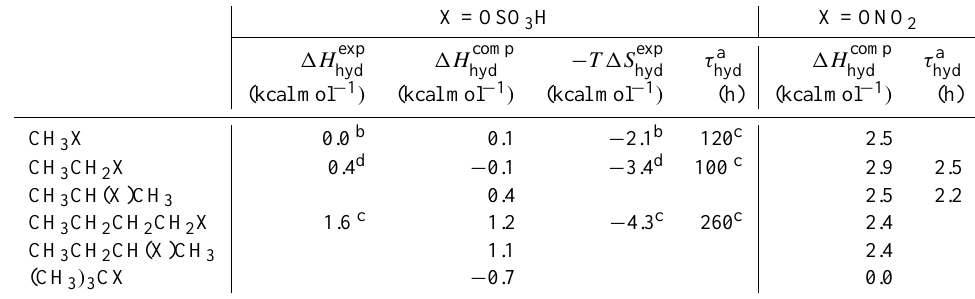
Table 1. Thermodynamic and kinetic parameters for the hydrolysis of monofunctional organonitrates and organosulfates.